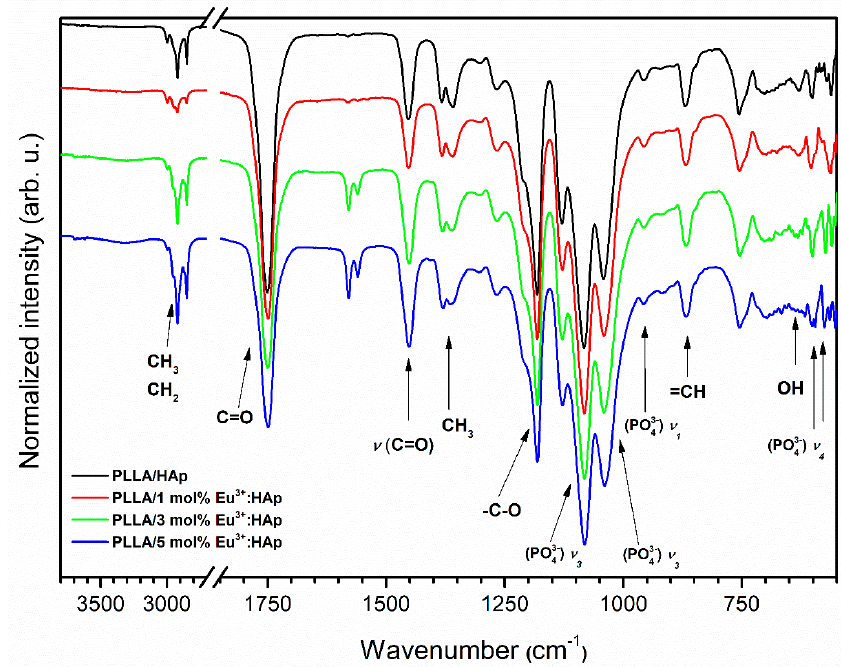
Figure 4. IR spectra of PLLA / x mol% Eu 3 + :HAp composites (where x = 0–5) obtained via extrusion in situ.